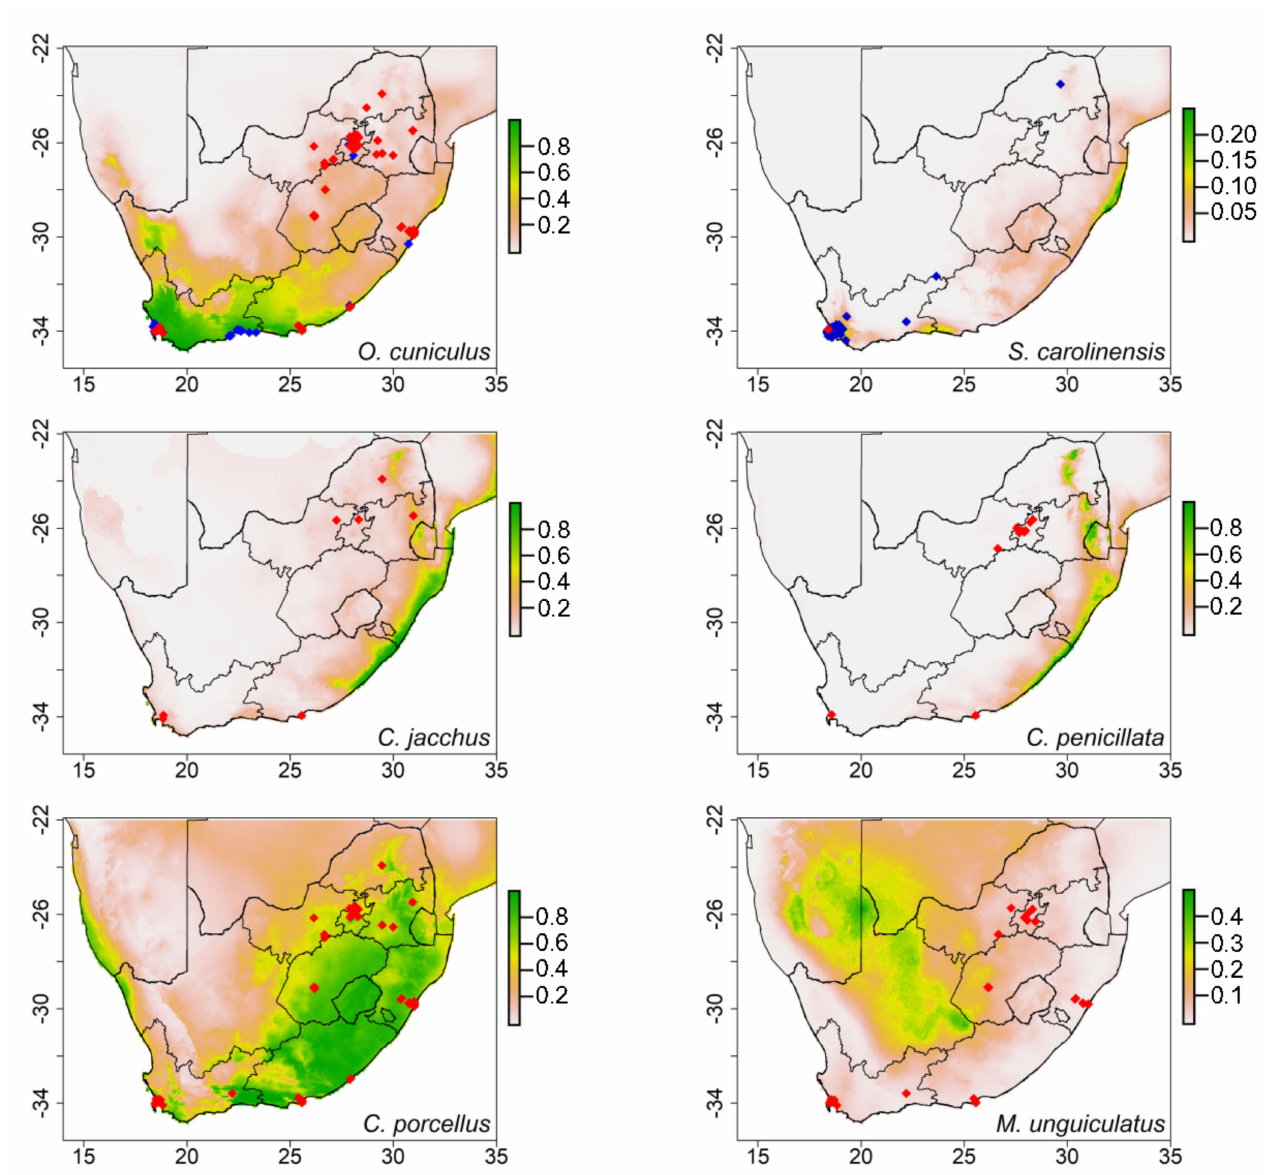
Figure 3. The potential distribution from ecological niche modeling showing the potential suitability for European rabbits ( Oryctolagus cuniculus ), eastern gray squirrels ( Sciurus carolinensis ), common marmosets ( Callithrix jacchus ), black-tufted ear marmosets ( Callithrix penicillata ), Guinea pigs ( Cavia porcellus ), and Mongolian gerbils ( Meriones unguiculatus ) in South Africa (Note: The color ramp threshold on the right measured the climatic suitability: green indicates the most climatic suitable areas, decreasing to yellow and orange, with light gold and white being unsuitable). Blue dots indicate current distribution records, and red dots indicate selling